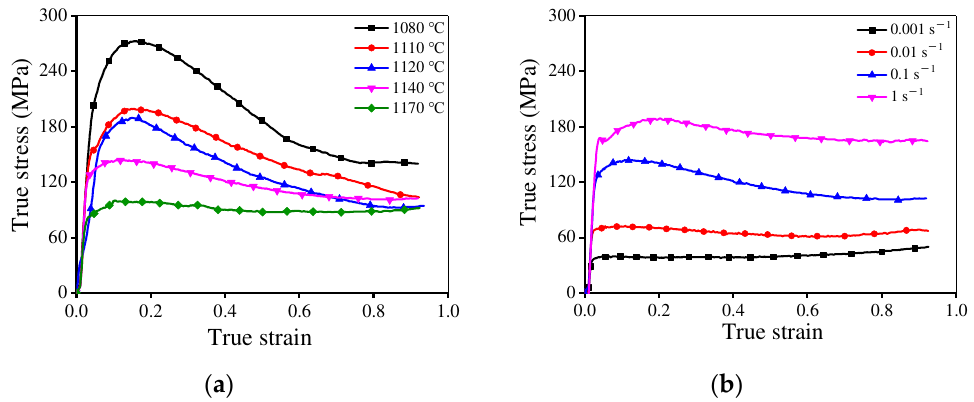
Figure 3. Typical true stress–strain curves of the HIPed superalloy at ( a ) . ε = 0.1 s − 1 ; ( b ) T = 1140 ◦